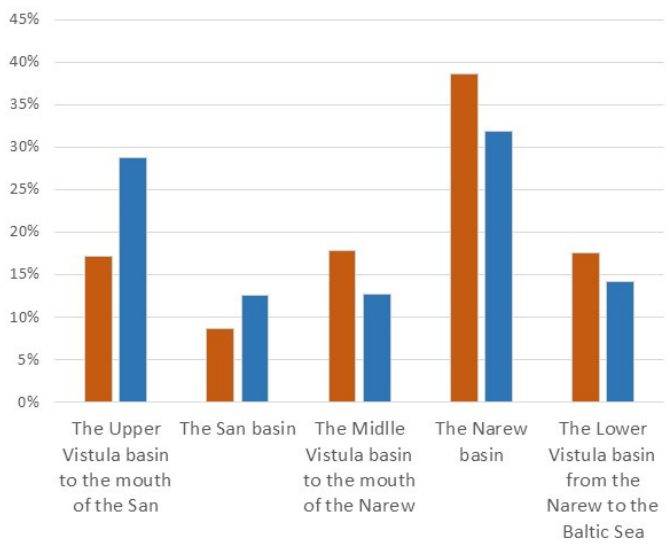
Figure 2. The runoff contribution of the Vistula sub-basins to the total runoff to the Baltic Sea. (Red) the share of the area in the total area of the Vistula basin; (blue) the share of the mean total outflow in the mean total outflow of the